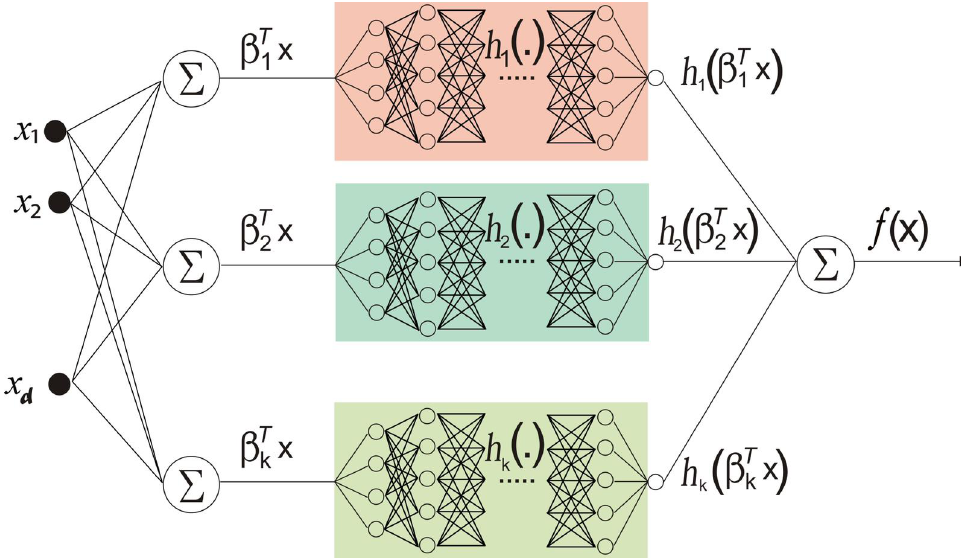
Figure 3. The proposed architecture of